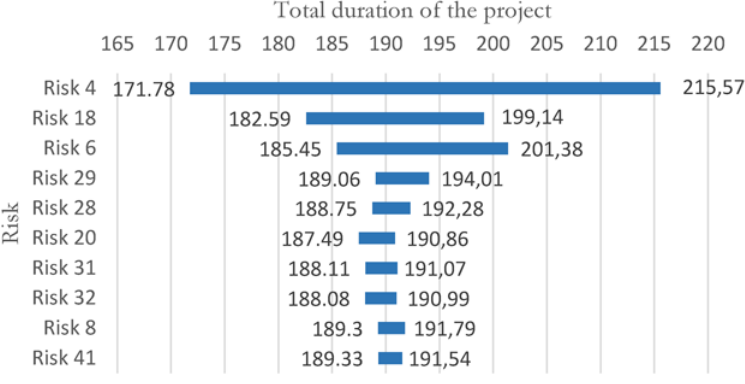
Tornado diagram of the schedule risks, simulation